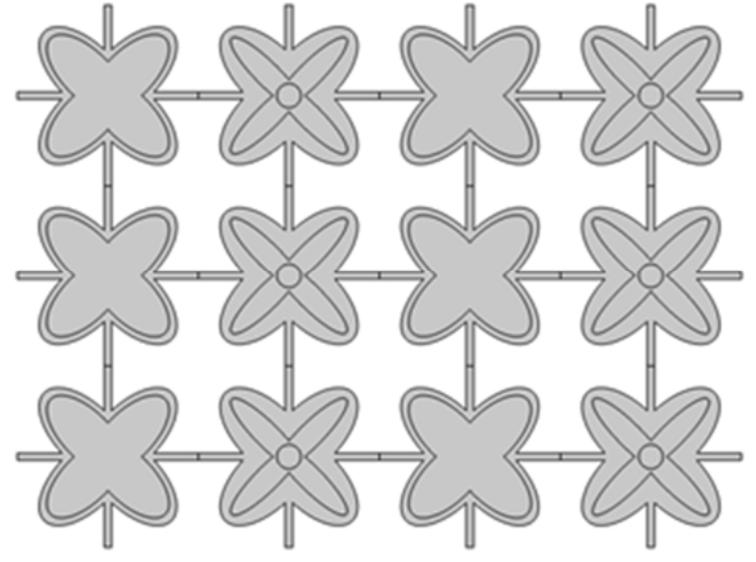
Figure 18. Mesh with combined geometry.